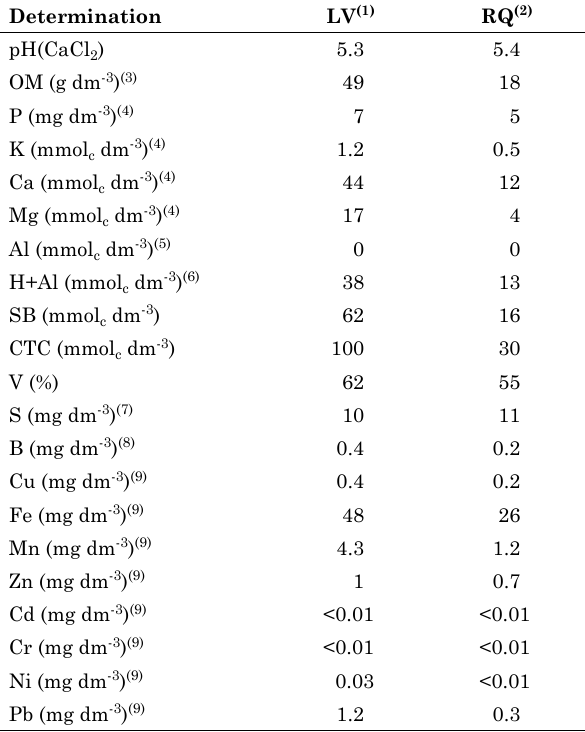
Table 2. Soil chemical properties after liming in an experiment with Cu sources on wheat